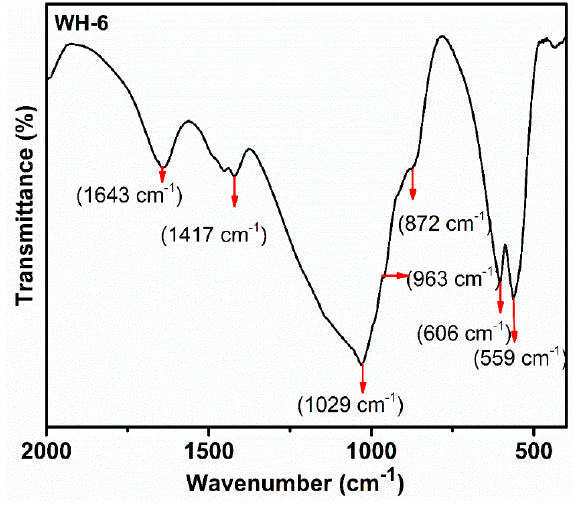
Figure 6. FTIR spectrum of WH-6 product (pure WH phase).